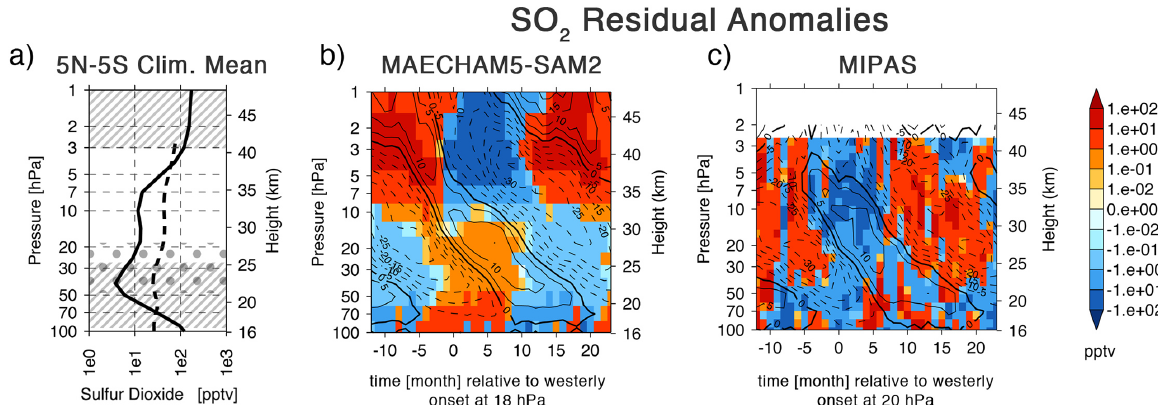
Figure 14. Comparison between the modelled SO 2 mass mixing ratio and Envisat/MIPAS observations from Höpfner et al. (2013). (a) Climatological mean profiles. The continuous line represents the model simulation and the dashed line MIPAS observations. Panels (b) and (c) show composited residual anomalies from the model and MIPAS, relative to the onset of residual westerlies at 18hPa and 20hPa, respectively. As before, model data are averaged between 5 ◦ N and 5 ◦ S for the years 1996–2006. MIPAS data have been obtained from the time series of measurements between July 2002 and April 2012. Composited zonal mean zonal wind contour lines in (c) have been obtained from the ECMWF ERA-Interim climatology, similarly to Figs. 2a and 8b. Pressure levels where QBO modulations are statistically significant are shaded grey. Hashed areas for the model and stippled for MIPAS.